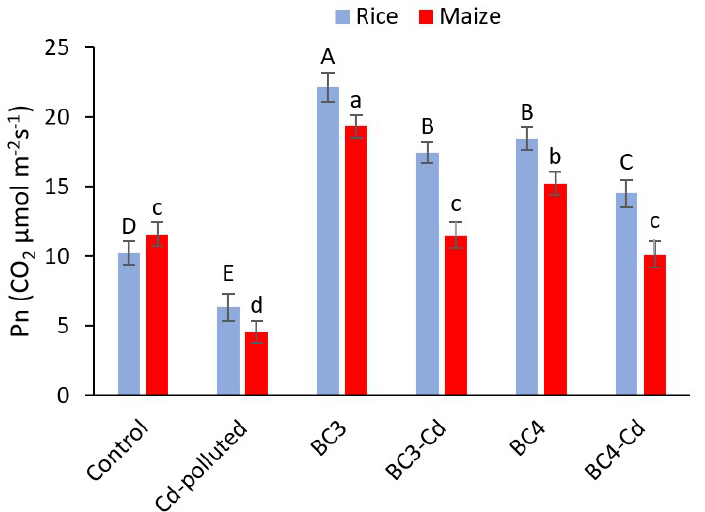
Figure 2. Effects of biochar and cadmium treatments on photosynthesis rate (Pn) in rice and maize field as representatives of C3 and C4 plants, respectively (means ± standard error). Significant differences of means are shown by different uppercase letters for rice and lowercase letters for maize ( p < 0.01). The values are means ± SD from three replicates ( n = 3). BC3: rice biochar, BC4: maize biochar, BC3 + Cd: rice biochar + cadmium, and BC4 + Cd: maize biochar + cadmium.